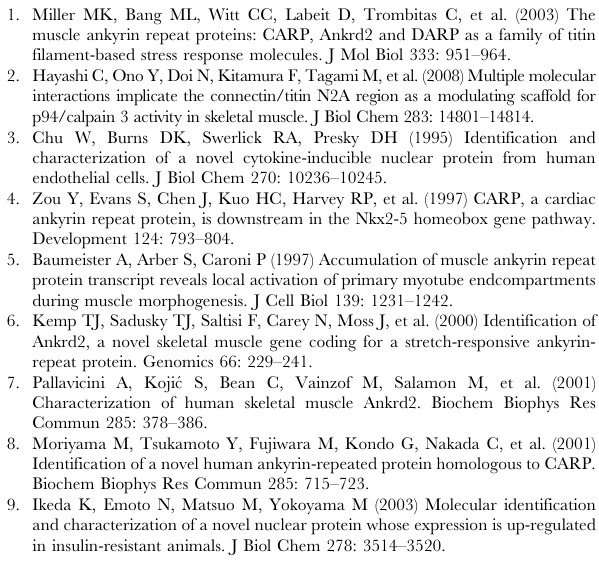
Figure S2 Coomassie blue stained gels demonstrating equal amounts of purified GST, GST tagged Ankrd2 and its deletants separated by SDS-PAGE. The same amounts of proteins were used in GST pull down reactions in mapping experiments, panel A corresponds to Figure 1B and panel B to Figure 1C. Purified recombinant proteins are designated as: A , almost full length Ankrd2 protein (aa 5–333); sA , Ankrd2 protein with a 97 aa Nterminal deletion (aa 98–333); N , N-terminal (aa 5– 120); NA , N-terminal plus ankyrin repeats (aa 5–284); CA , C- terminal plus ankyrin repeats (aa 121–333); C , C-terminal (aa 280–333). Molecular size of proteins is given on the left, in kDa. (TIF) Table S1 Genes downregulated in Ankrd2 silenced myotubes. Table S2 Genes upregulated in Ankrd2 silenced myo- tubes. Table S3 Differentially expressed genes in infected (non silenced) compared to uninfected CHQ5B cells. Table S4 KEGG pathways with 7 or more